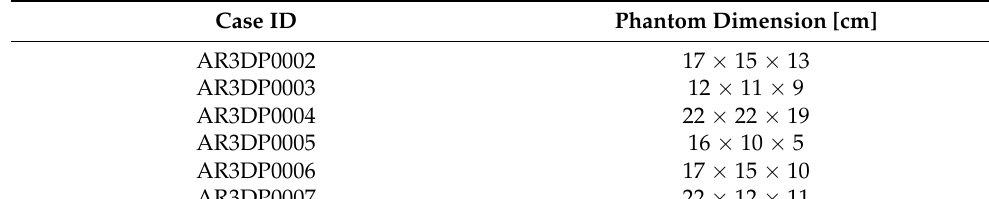
Table 3. Size dimensions of the manufactured patient-specific 3D-printed phantoms.